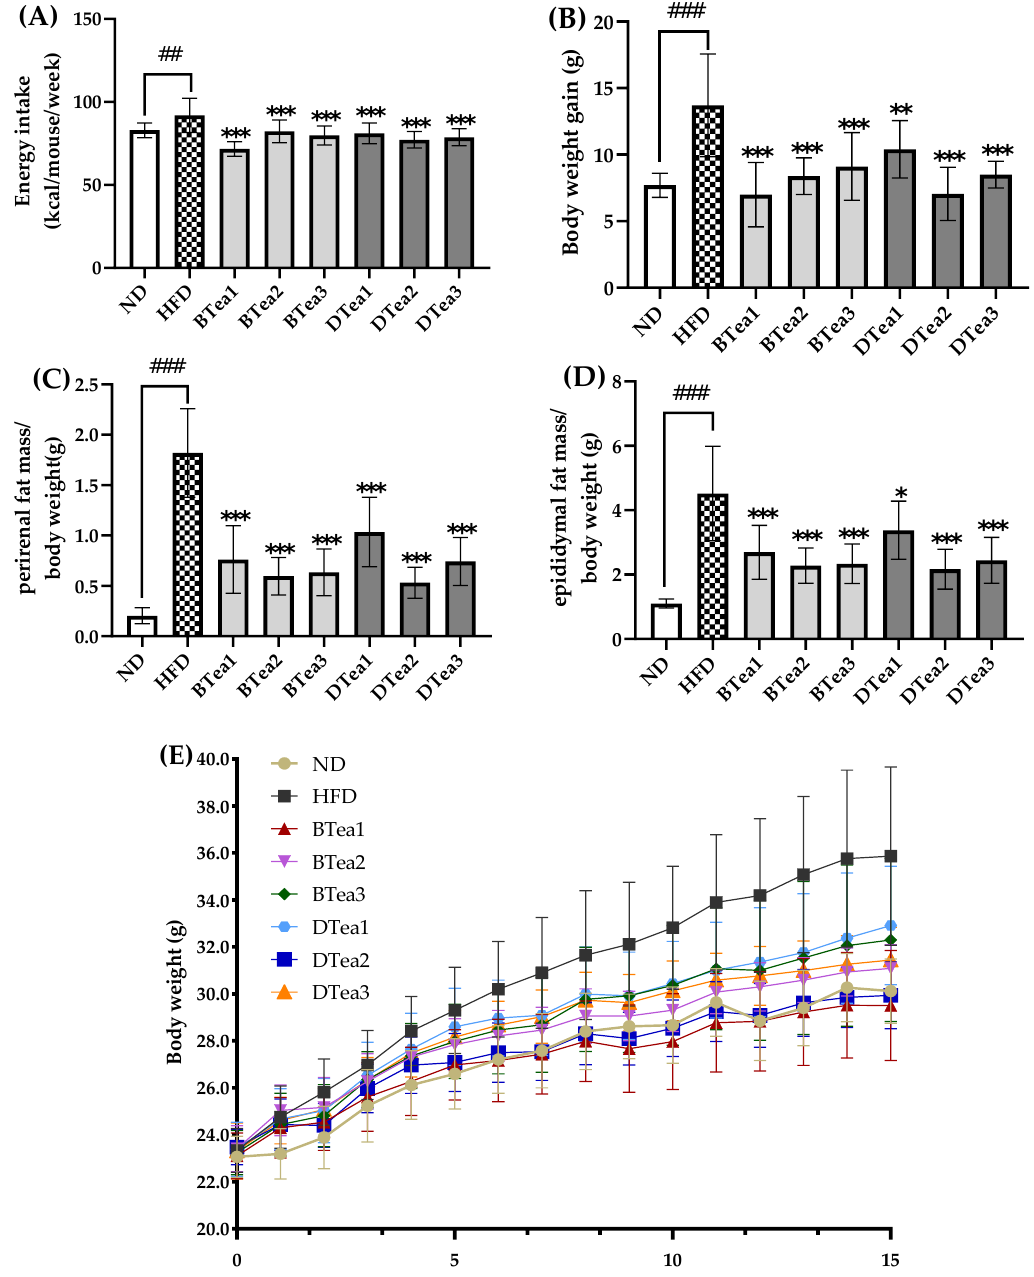
Figure 2. The effects of different black and dark teas on obesity. ( A ) Energy intake, ( B ) body weight gain, ( C ) the ratio of perirenal fat mass to body weight, ( D ) the ratio of epididymal fat mass to body weight, ( E ) and body weight throughout the 15-week intervention. The results are expressed as mean ± standard deviation. ND, the control group (normal diet group); HFD, the model group (high-fat diet group); BTea1, selenium-enriched black tea; BTea2, Dianhong tea; BTea3, Yingde Black tea; DTea1, Fu Brick Tea; DTea2, Liupao tea; DTea3, selenium-enriched dark tea. ## p < 0.01 and ### p < 0.001f for the HFD group, compared with the ND group; * p < 0.05, ** p < 0.01, *** p < 0.001, the tea extract supplementary groups compared with the HFD group.